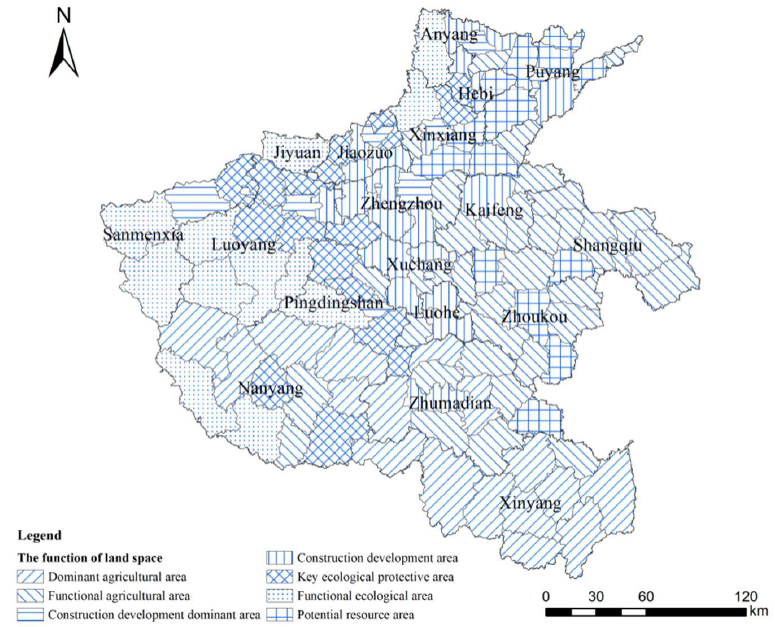
Figure 6. Evaluation results of land space development zoning in Henan province.